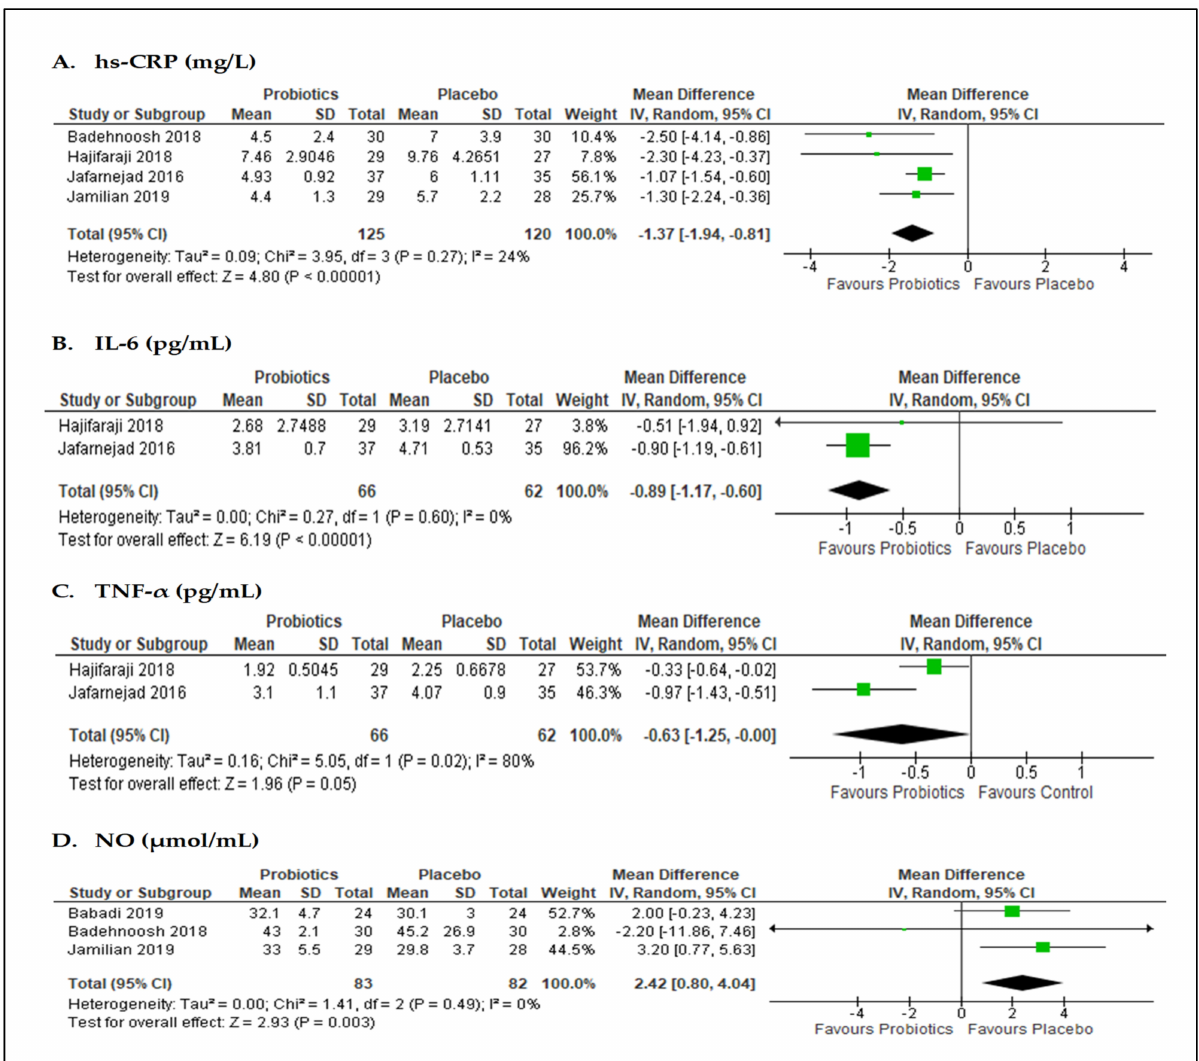
Figure 4. Forest plots for the meta-analysis of inflammatory markers: ( A ) hs-CRP, high-sensitivity C-reactive protein; ( B ) IL-6, interleukin; and ( C ) TNF- α , tumor necrosis factor-alpha; and ( D ) NO, nitric